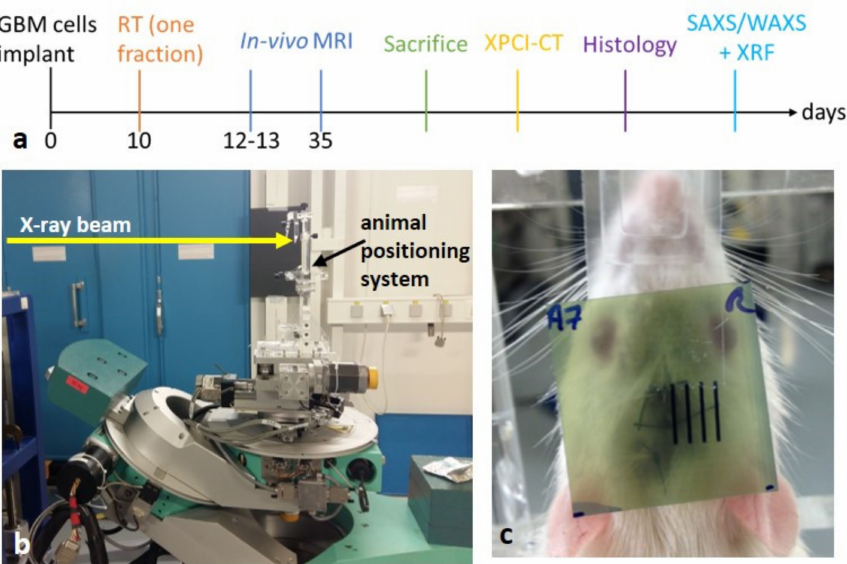
Figure 1. Timeline of the experimental protocol: ( a ) the days of the sacrifice depends on the groups and/or on the decided time points. Animals’ irradiation setup: the synchrotron X-ray beam, indicated by the yellow arrow, is filtered by some metal absorbers and shaped by slits collimators to the desired vertical and horizontal dimensions and the goniometer allows for the precise positioning of the animal by means of translation and rotation motor stages that are remotely controlled ( b ); picture of an irradiated rat with a GafChromic film placed just before the animal for checking the correct delivery of the X-ray beam ( c